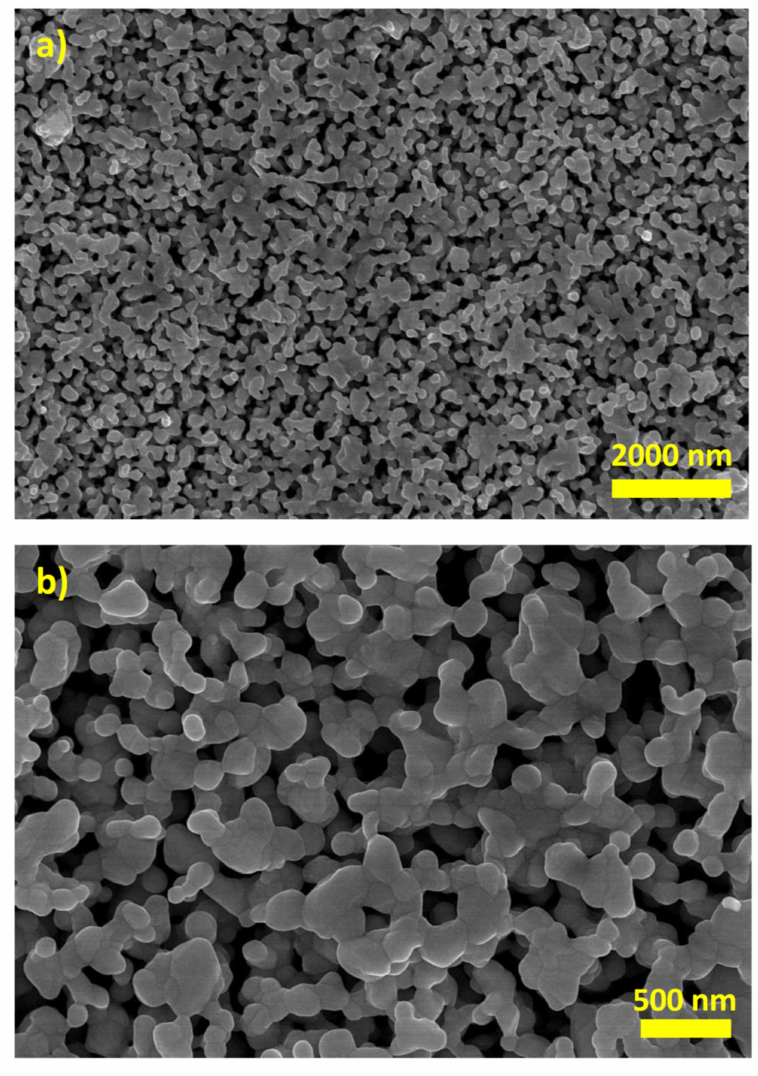
Figure 2. Scanning electron microscopy (SEM) images of the roughened silver electrode at two different magnifications ( a , b